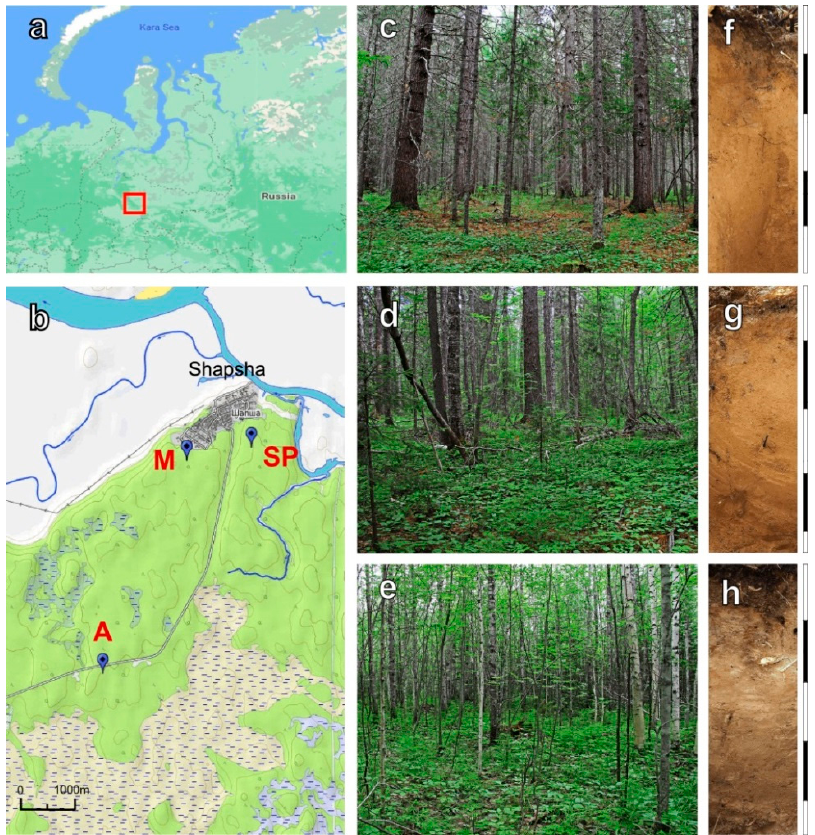
Figure 1. Location of the study sites ( a , b ). SP, Siberian pine forest; M, mixed forest; A, Aspen forest. Images of the studied forest ecosystems: ( c ) Siberian pine forest, ( d ) mixed forest, ( e ) Aspen forest, and the corresponding soil profiles ( f – h ). Scale (in ( f – h )), 10 cm. The climate of the region is subarctic Dfc according to Köppen climate classification, with long cold winters (average winter air temperature is − 17.5 °C), short warm summers (average summer air temperature is 16.0 °C), and annual average air temperature of − 0.4 °C for the 1981–2010 period (www.pogodaiklimat.ru, accessed on 5 November 2021). The annual average precipitation is 549 mm, concentrated in the period from June to October. Snow cover lasts for 187 days on average, from October to May (www.pogodaiklimat.ru, accessed on 5 November 2021). Ground water depth is more than 5 m. According to WRB classification, all plots have the same soil type—Albic Podzol with sandy loam texture. Soil profile consisted of a thin O layer (mean depths are 0–2 cm) of plants litter, a topsoil